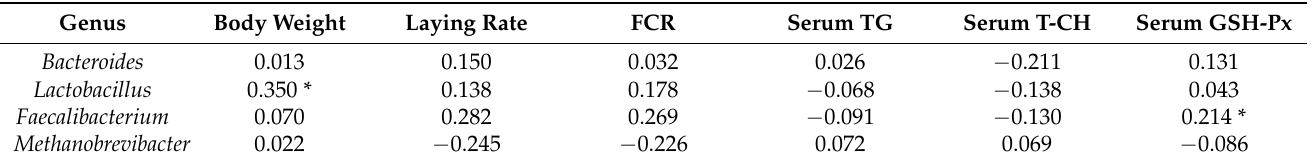
Table 5. Correlations of differentially detected caecal bacterial genera with productive performance and serum biochemical indices of the four